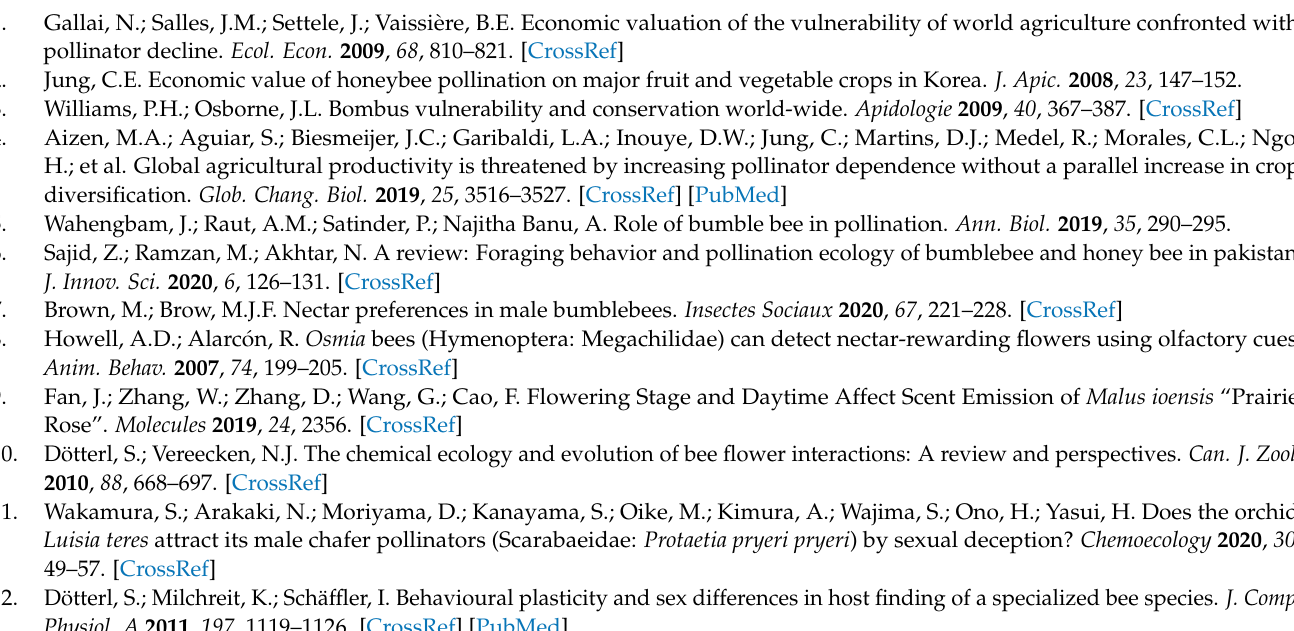
Data in the table are mean ± SE. Lowercase letters mean the significance between different volatiles at the same concentration (same column), and uppercase letters mean the significance between the same volatiles at different concentrations (same row) ( p <